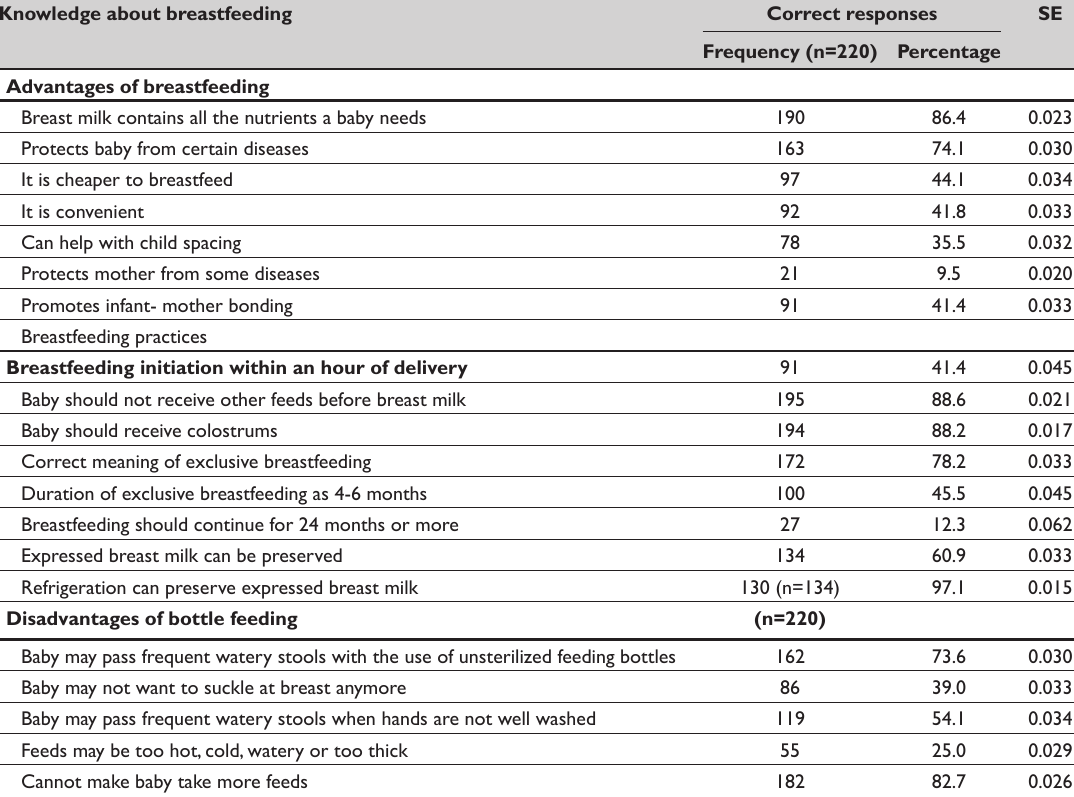
Table 2: Distribution of mothers according to knowledge of breastfeeding Knowledge about